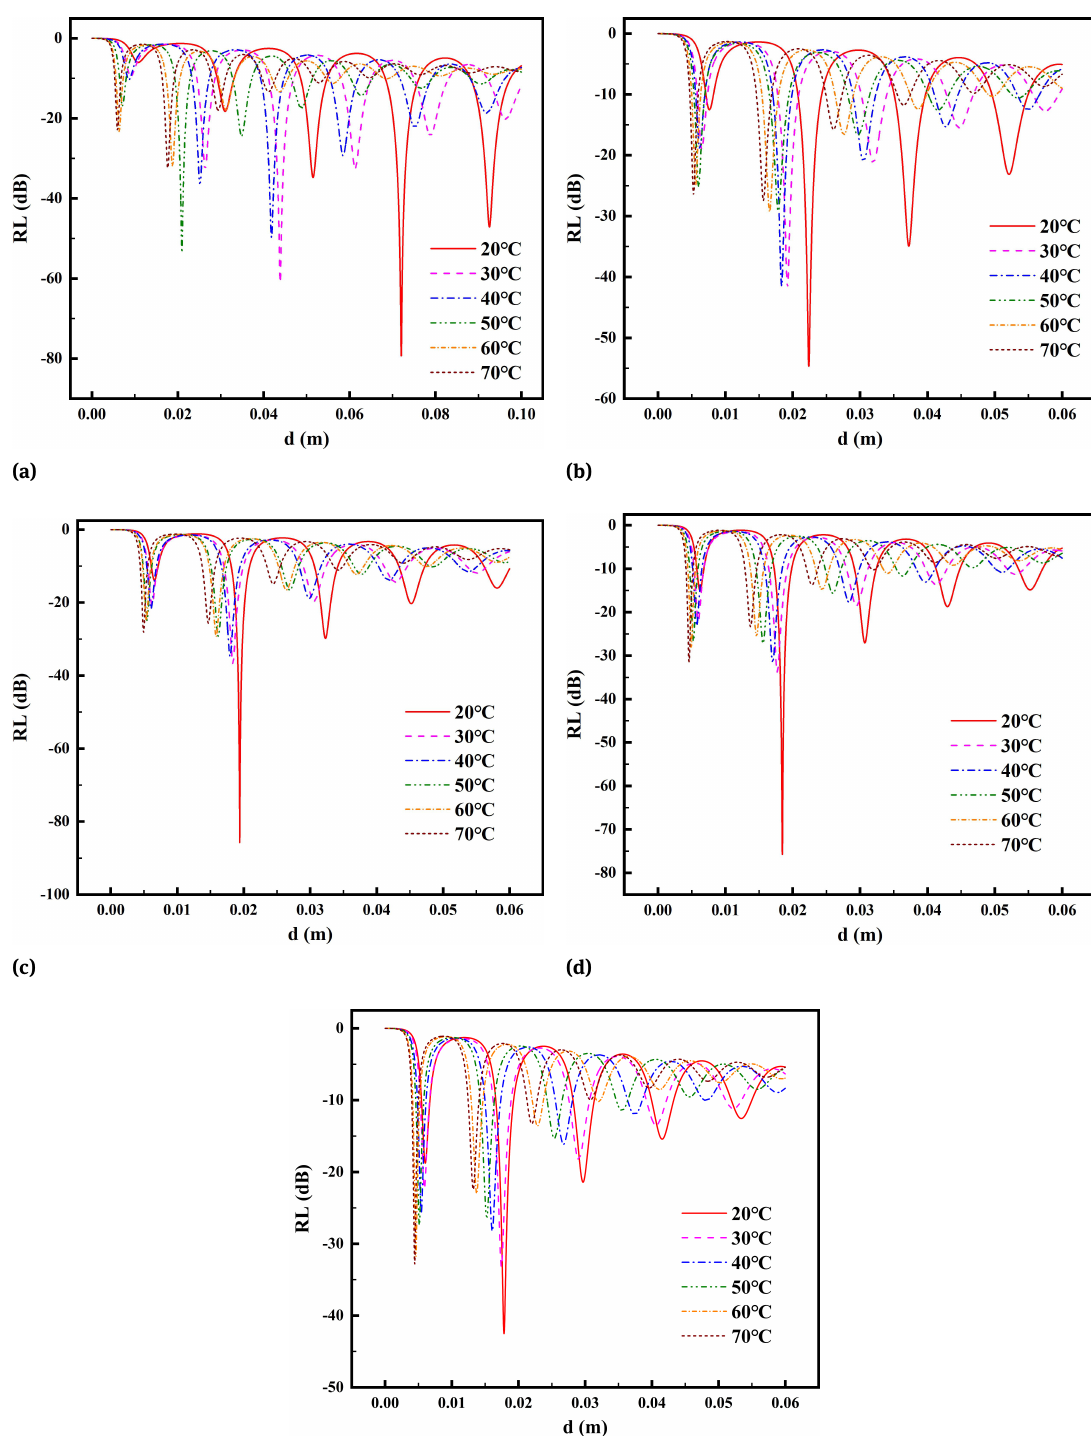
Figure 3: Temperature dependence (20, 30, 40, 50, 60, 70 ∘ C) of reflection loss of paracetamol as thickness varies from 0 to 0.1 m for moisture contents: (a) 0.2 kg kg −1 , (b) 0.4 kg kg −1 , (c) 0.6 kg kg −1 , (d) 0.8 kg kg −1 , (e) 1.0 kg kg −1